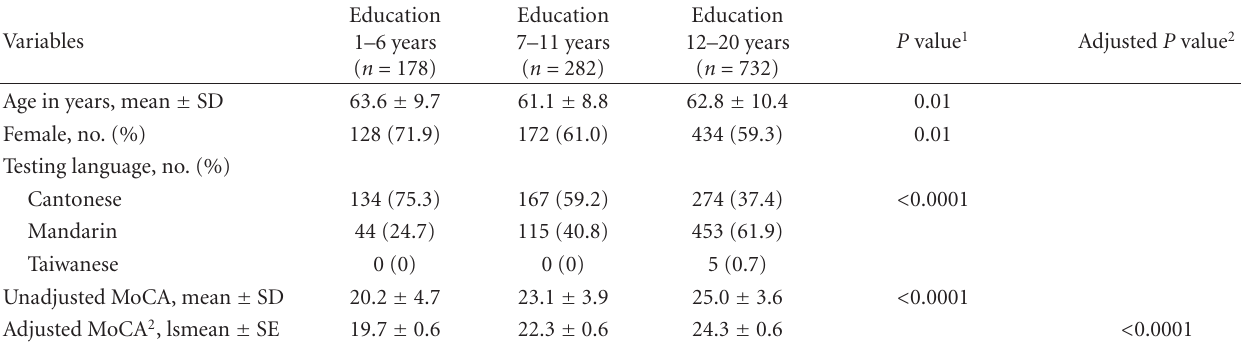
Table 3: Comparison of age, gender, test language, and MoCA-ChLA score among the three education groups.